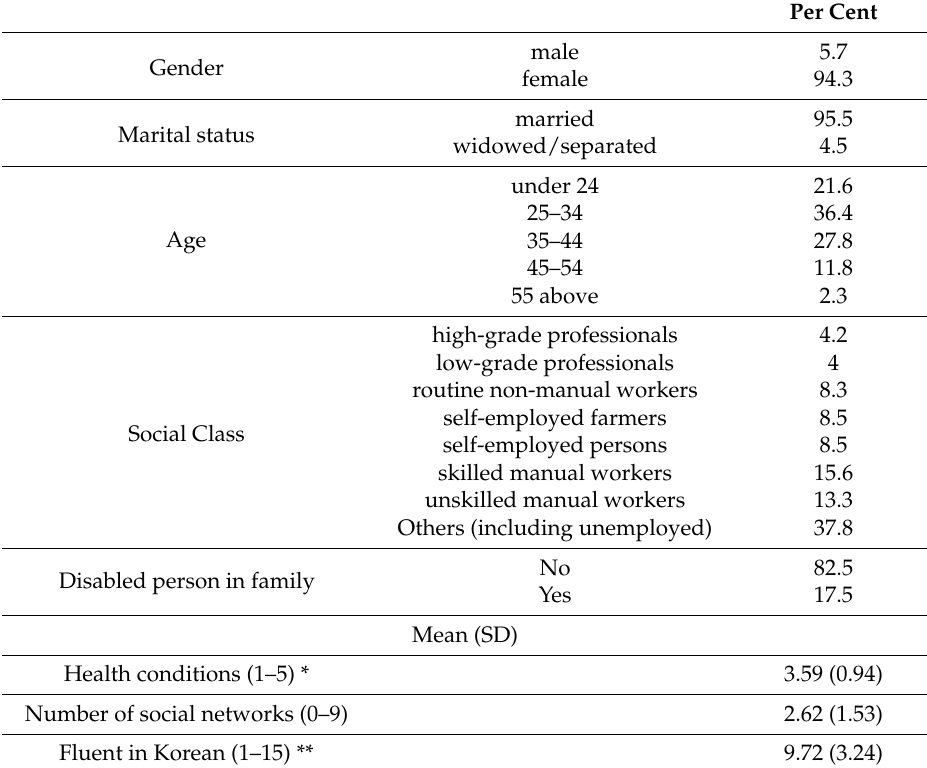
Table A1. Socio-economic characteristics of multicultural